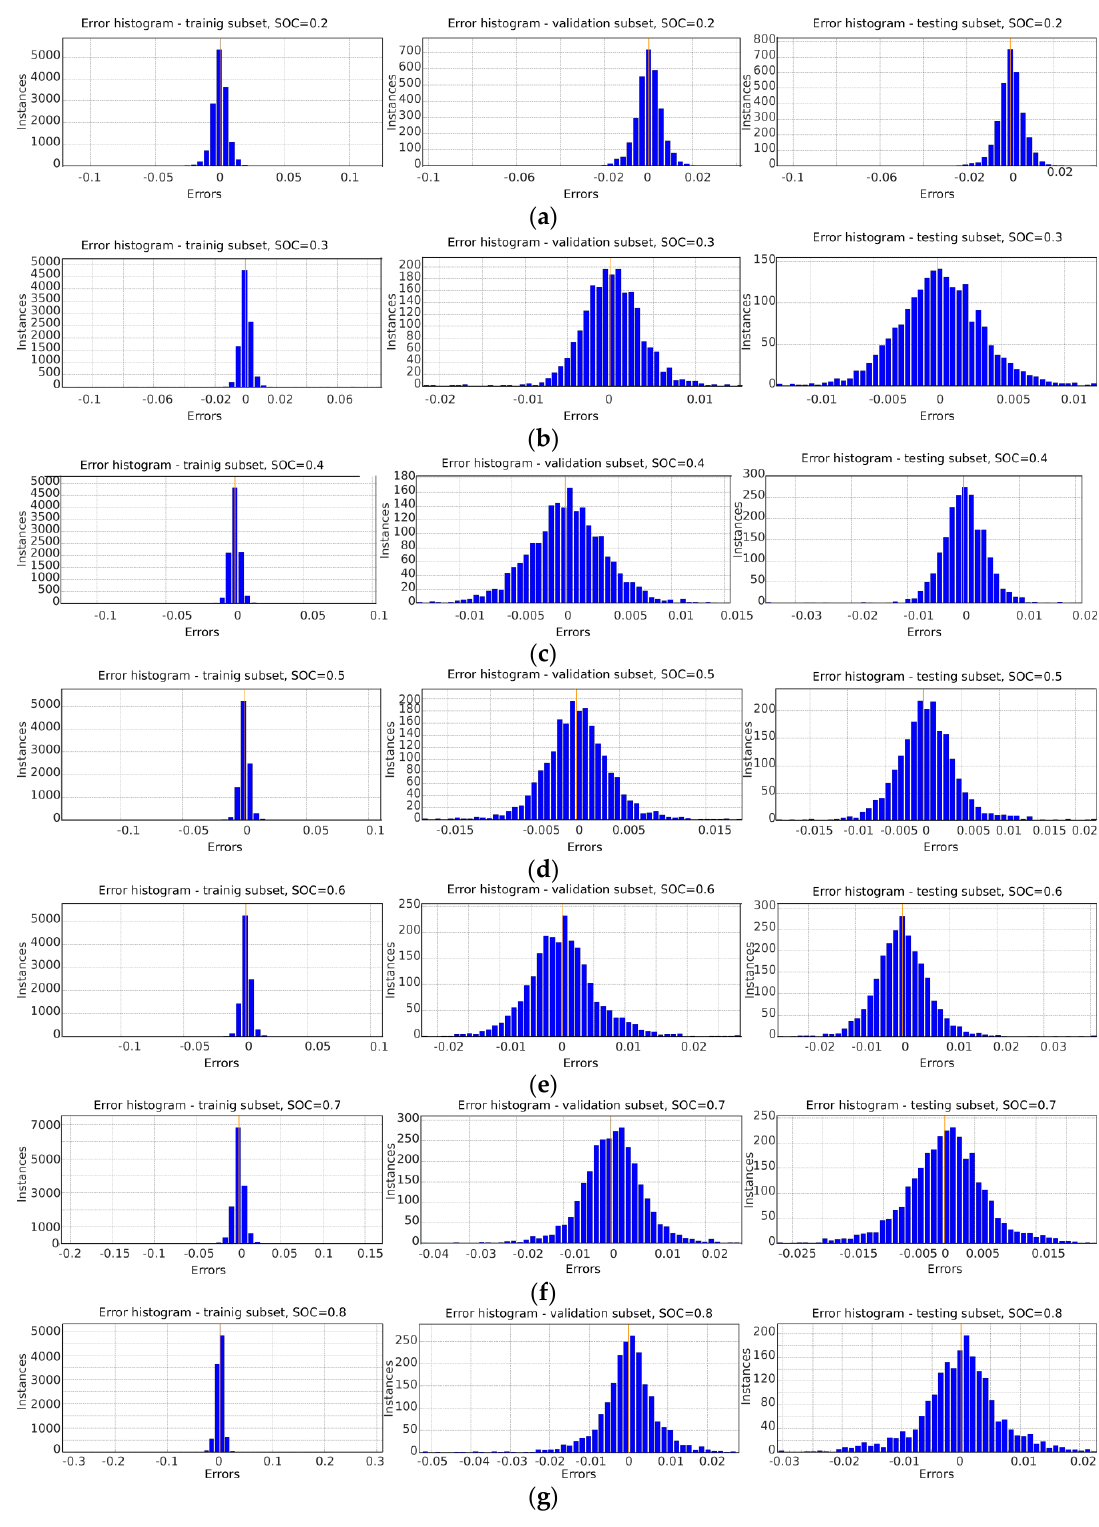
Figure 9. Error histograms of NARX-ANN models after training, respectively for: ( a ) SOC = 0.2; ( b ) SOC = 0.3; ( c ) SOC = 0.4; ( d ) SOC = 0.5; ( e ) SOC = 0.6; ( f ) SOC = 0.7 and ( g ) SOC = 0.8 in pulse work cycle.